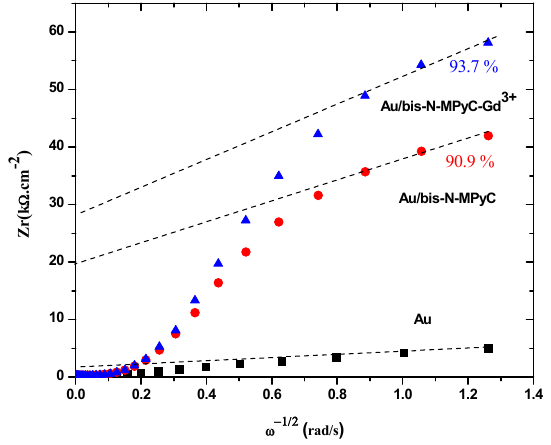
Figure 5. Determination of the coverage of bis-N-MPyC and bis-N-MPyC–Gd 3+ thin films.